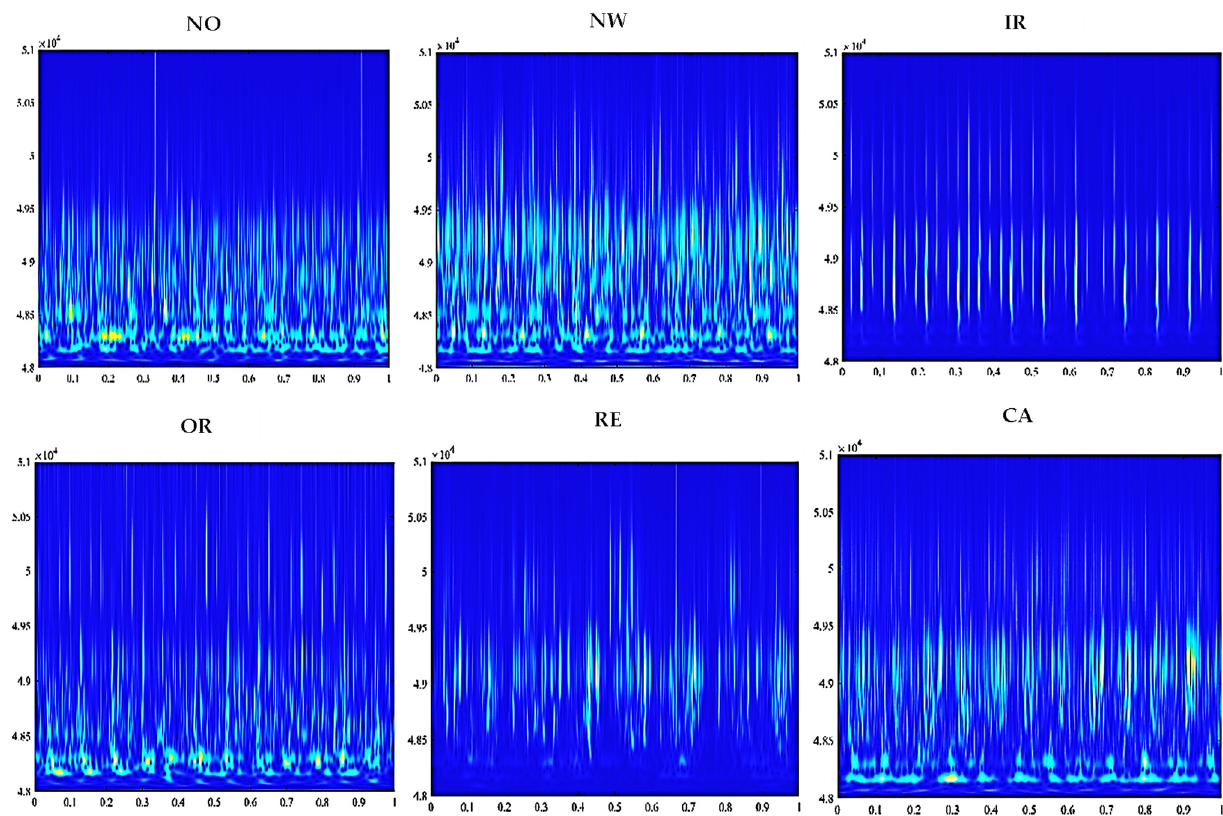
Figure 25. Examples of the ST-based computed images of bearing vibration signals with six different health conditions that were described in Section 2.1.1 above.